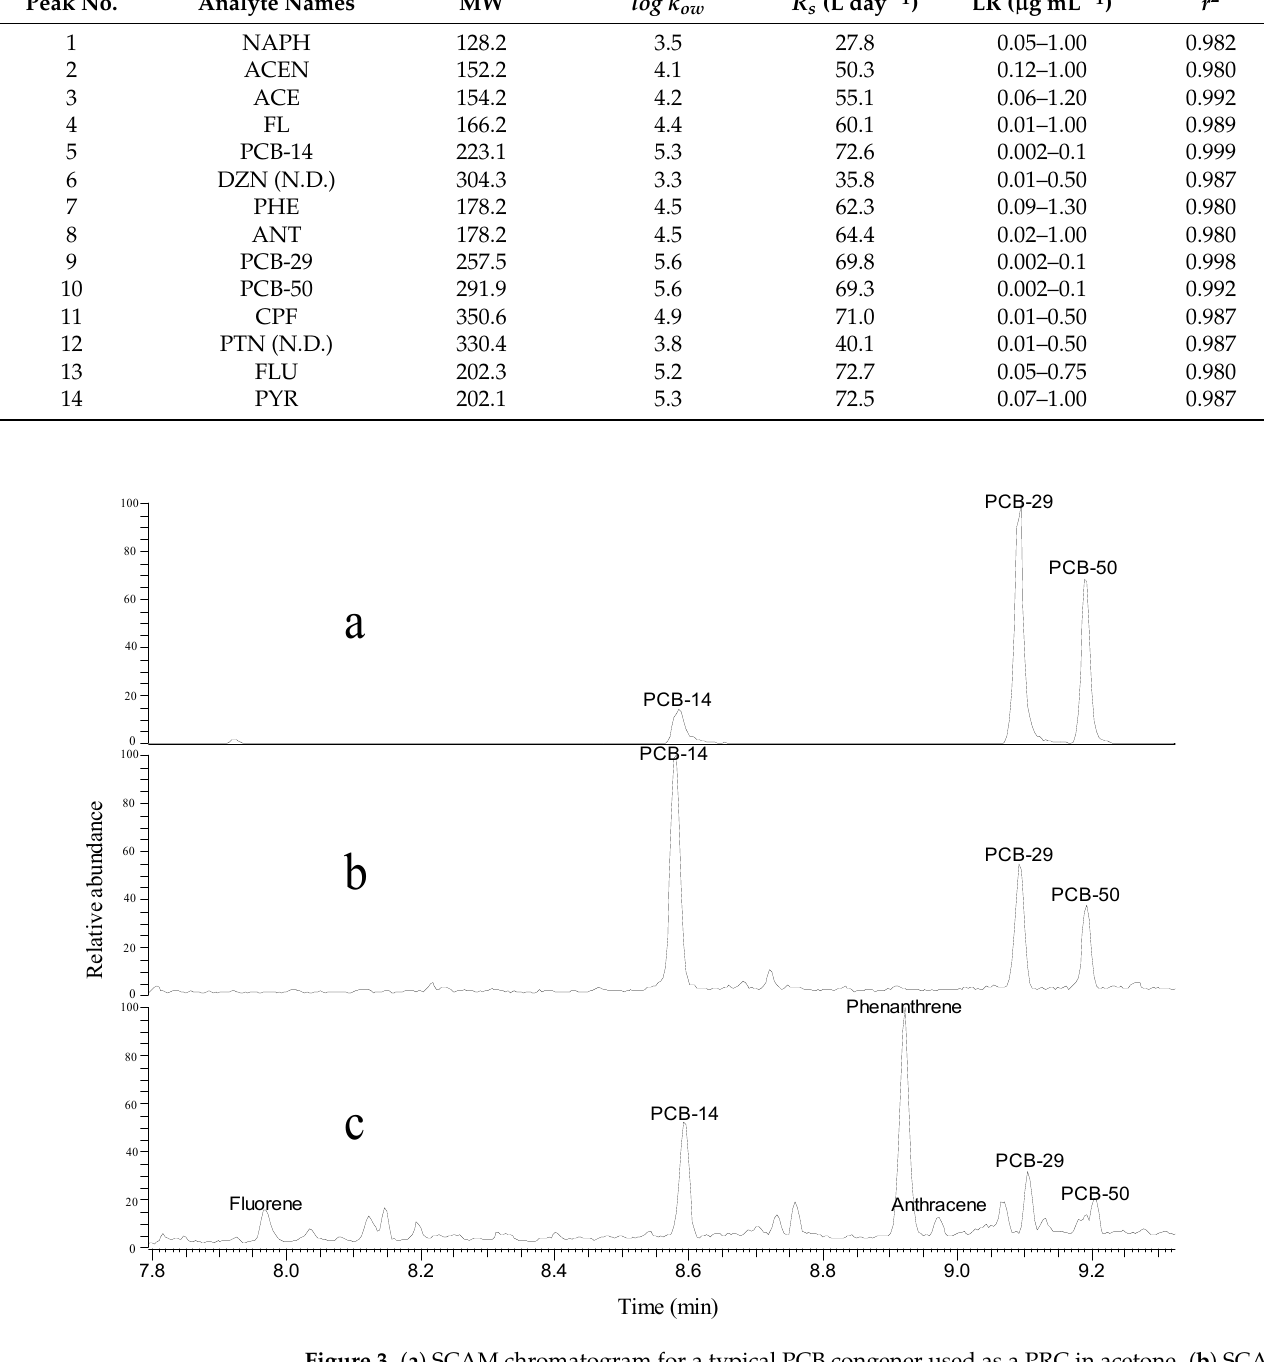
Figure 3. ( a ) SCAM chromatogram for a typical PCB congener used as a PRC in acetone. ( b ) SCAN chromatogram of the typical SPMD blank at ten days. ( c ) SCAN chromatogram of the SPMD deployment during ten days, including PRCs and some target